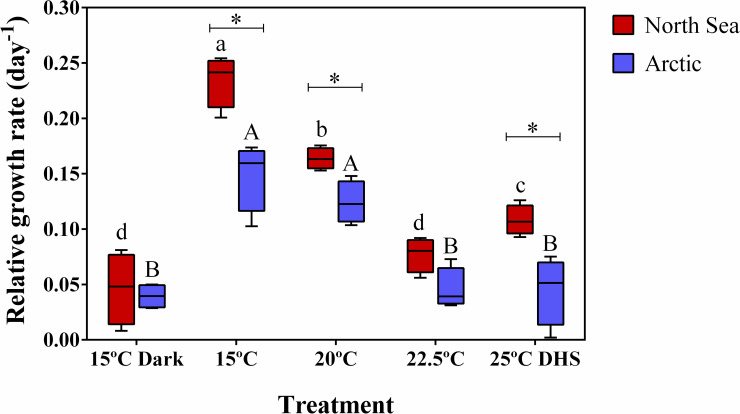
Effect of heat stress and darkness on gametophyte growth.Relative growth rate of gametophytes from the North Sea and Arctic populations of Laminaria digitata after 8 days in different treatments (15°C dark, 15°C, 20°C, 22.5°C and 25°C DHS). Box plots with median, boxes for 25th and 75th percentiles and whiskers indicating min and max values (n = 4). * indicates a significant difference between populations per treatment (p<0.05). For each population, different letters above boxplot bars (lowercase letters for the North Sea population and upper case letters for the Arctic population) indicate differences between treatments (p<0.05). See Table 2 for statistics.